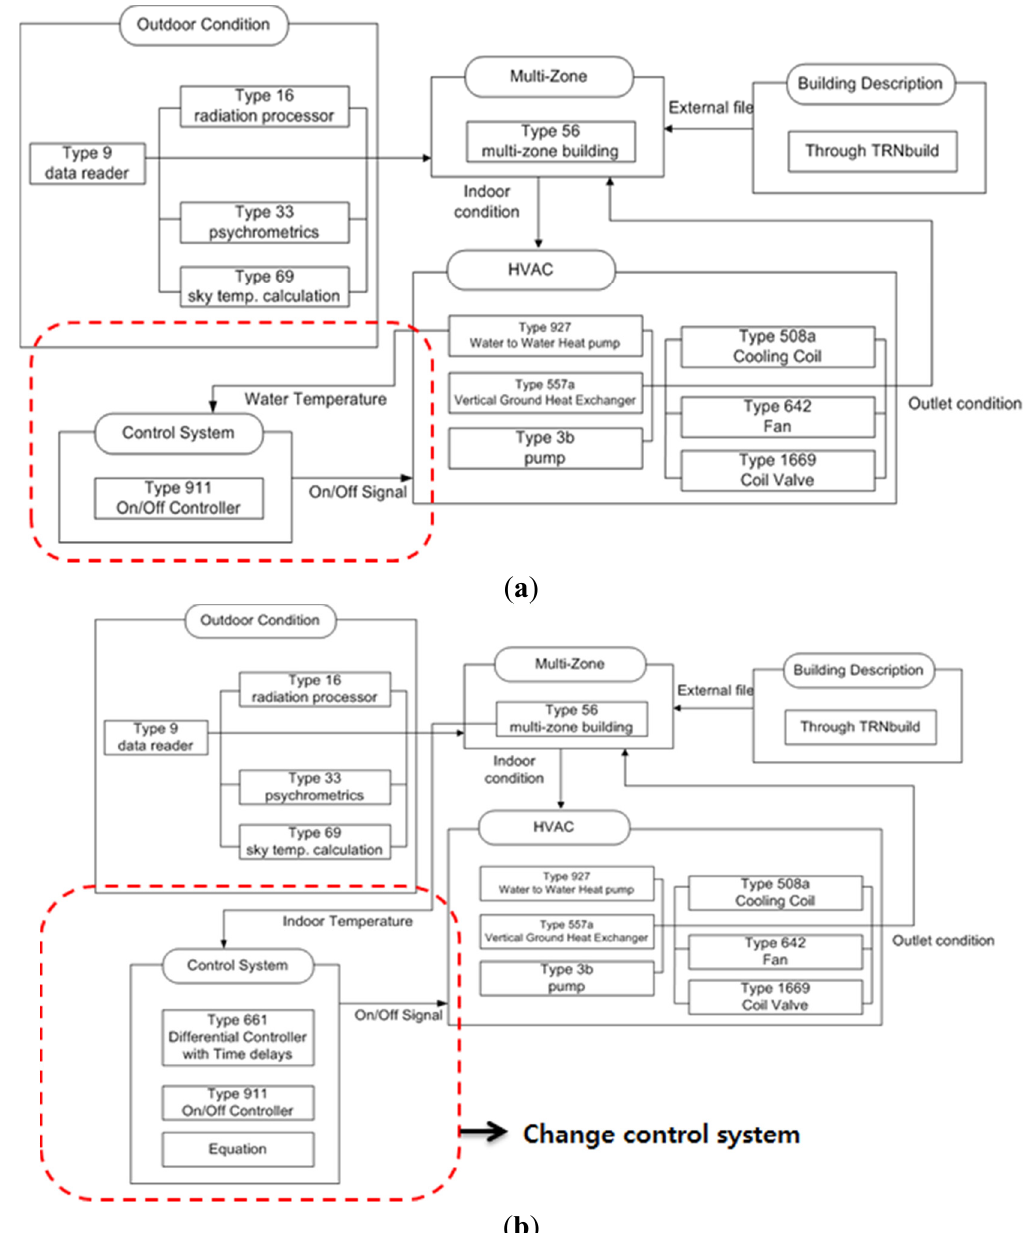
Figure 11. Simulation flow chart of the Multi-GHP system: ( a ) existing operation condition of Multi-GHP system (Case 1-1); ( b ) sequencing operation condition of Multi-GHP system (Case